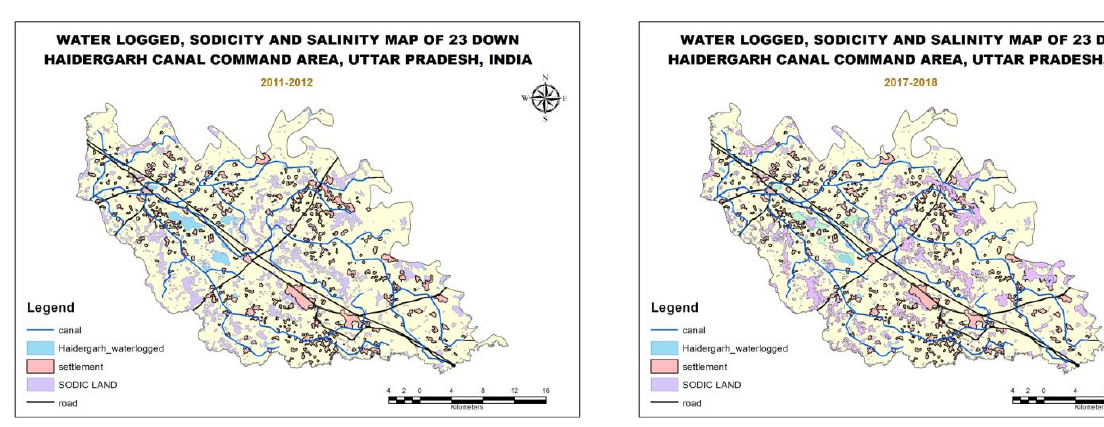
Figure 10: Land use categories by Digitization for the year